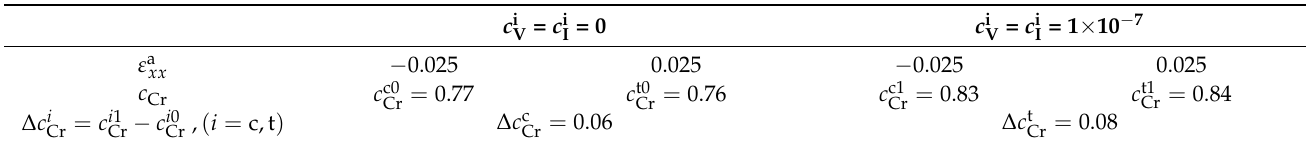
Figure 5. The concentration distributions of Cr and vacancy across the Cr- enriched α′ phase , and vacancy at 700 K under different strains at t * = 71. ( a ) c i and ( d ) local magnification of the concentration in Figure 5c. Table 2. The concentration changes of Cr with and without defect at 700 K under the effects of compressive and tensile strains.